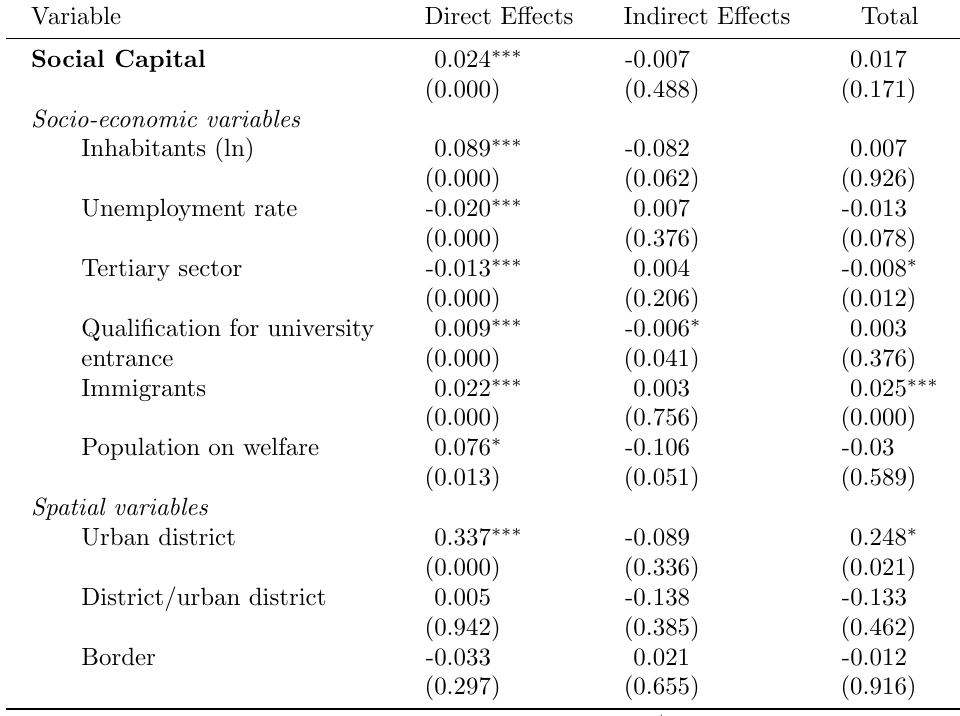
Table 2: Direct and indirect effects of socio-economic variables on economic well-being